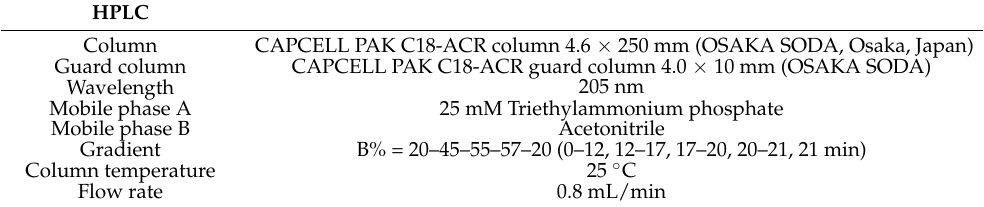
Table 1. High-performance liquid chromatography (HPLC) conditions for tomatidine and α -tomatine concentration